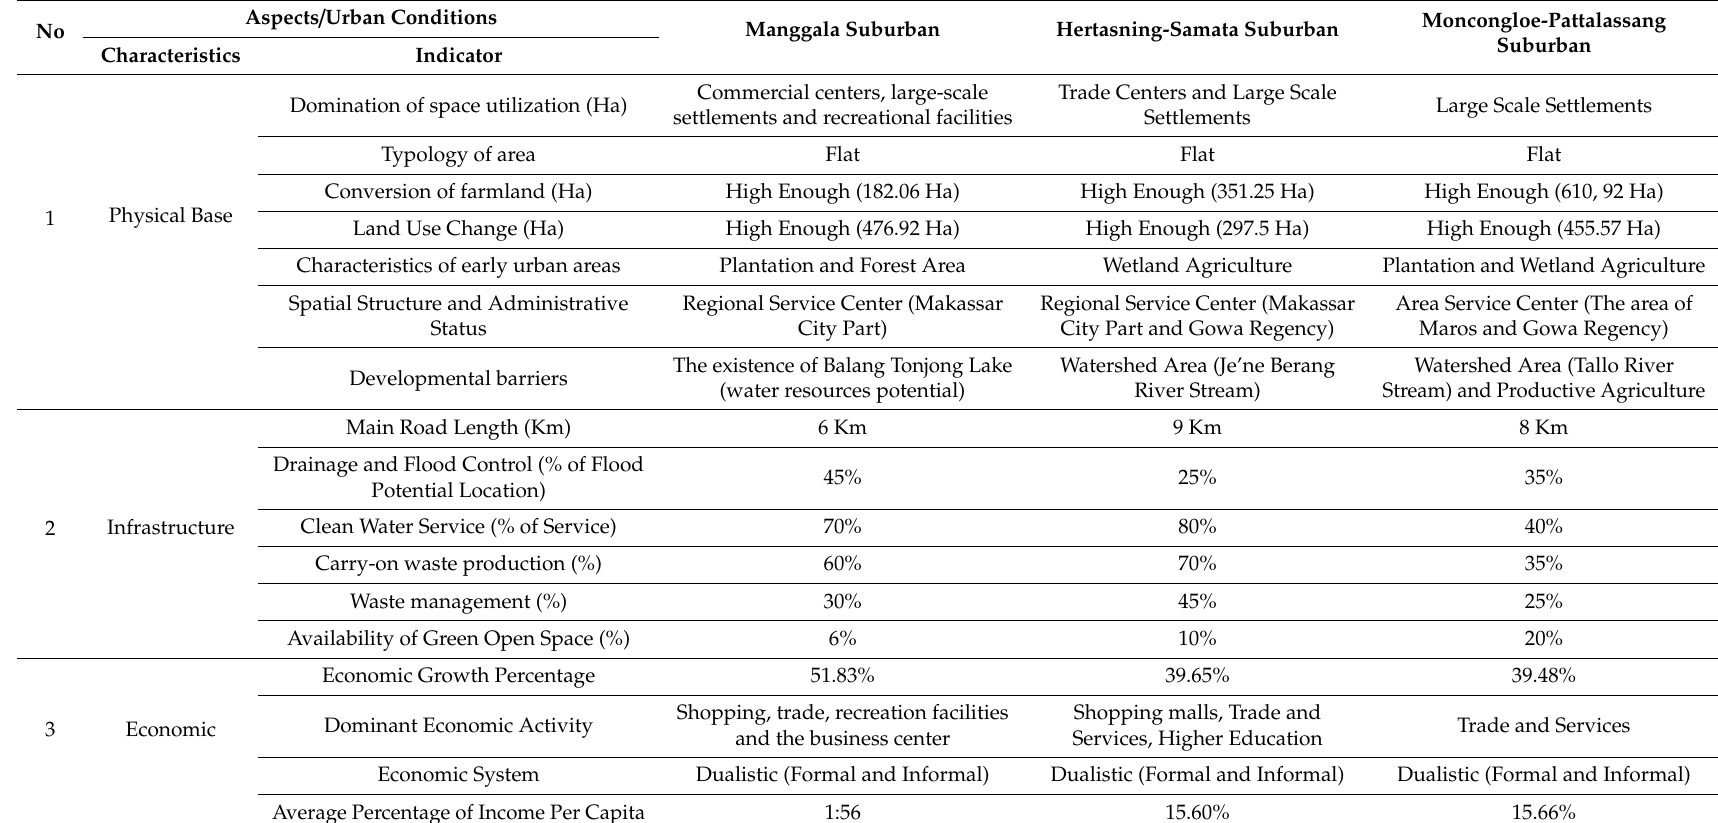
Table A5. Comparative Development of Mamminasata Metropolitan Urban